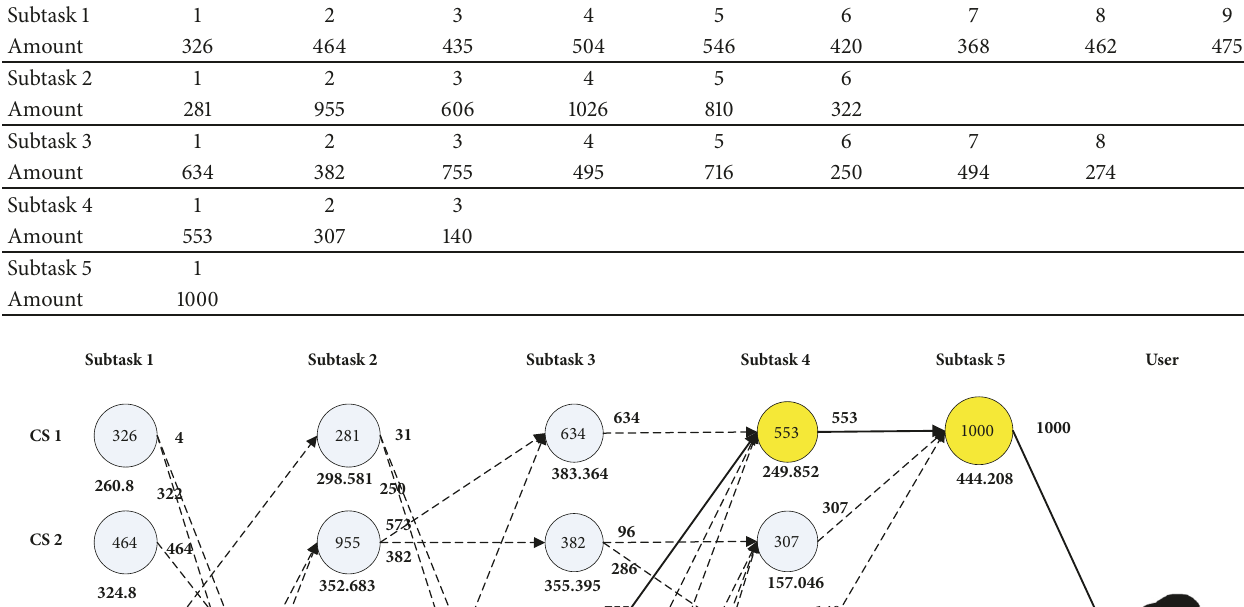
Table 5: The subtask amount of every CS.